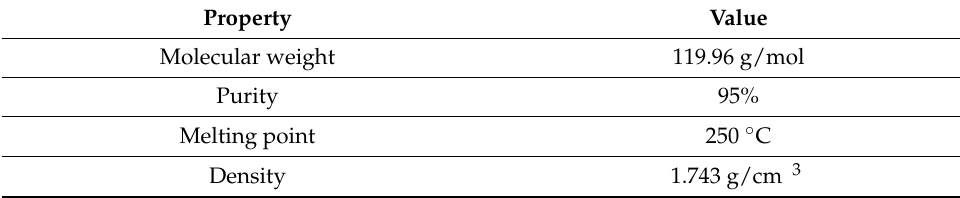
Table 2. Basic properties of CF 3 COOLi.